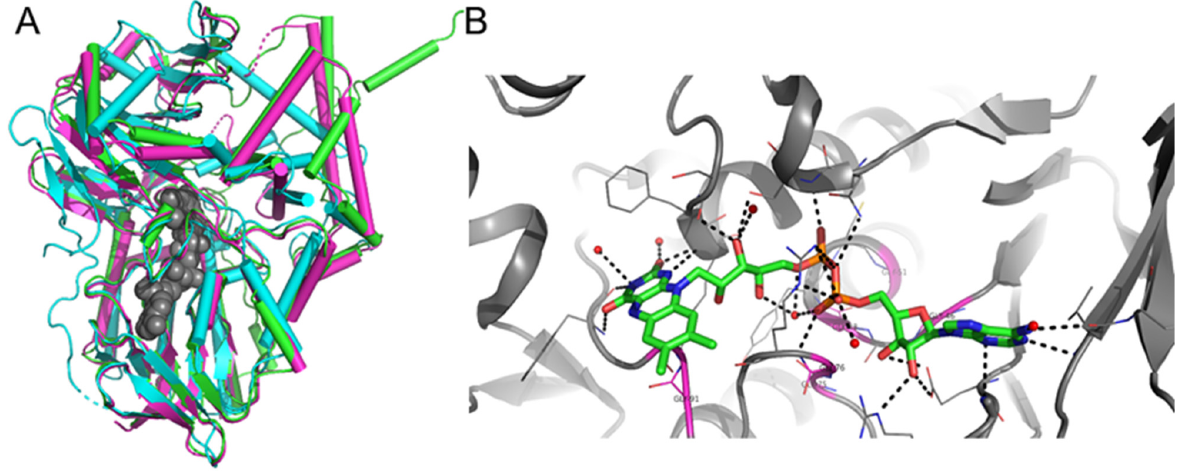
Figure 1. Comparison of the 3D structures of monoamine oxidases (MAO) and FAD binding to MAO. ( A ) Aligned